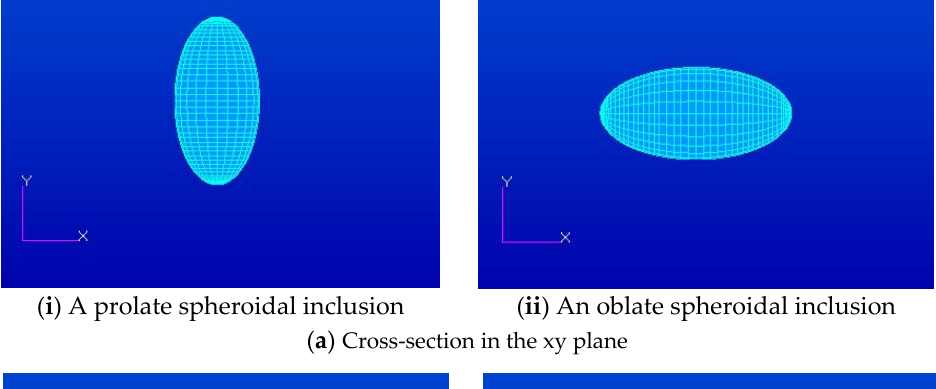
Figure 25. VIEM results for the normalized shear stress components ( a ) σ xy / σ oxy , ( b ) σ xz / σ oxz and ( c ) σ yz / σ oyz along ( i ) the x–axis inside and ( ii ) the circumferential direction of the isotropic prolate sphe- roidal inclusions (Iso_01, Iso_05 and Iso_06) with a/b = c/b = 0.75 (b = 6 mm) under remote shear loading ( σ oxy , σ oxz and σ oyz ).